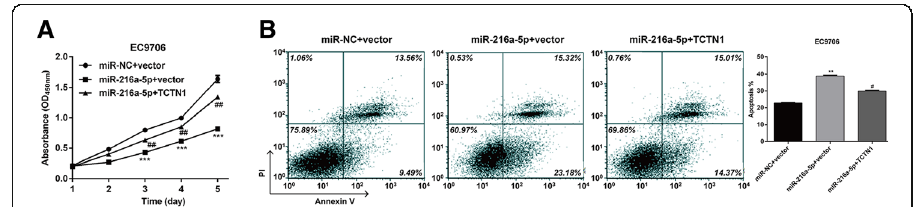
Restoration of TCTN1 abolished the effects of miR-216a-5p on cell proliferation and apoptosis